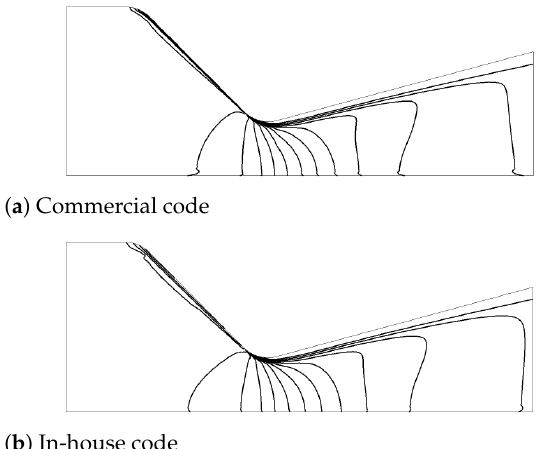
(cid:2) (cid:3) 7.2 10 − 5 0.001 . ∈ · · · ·